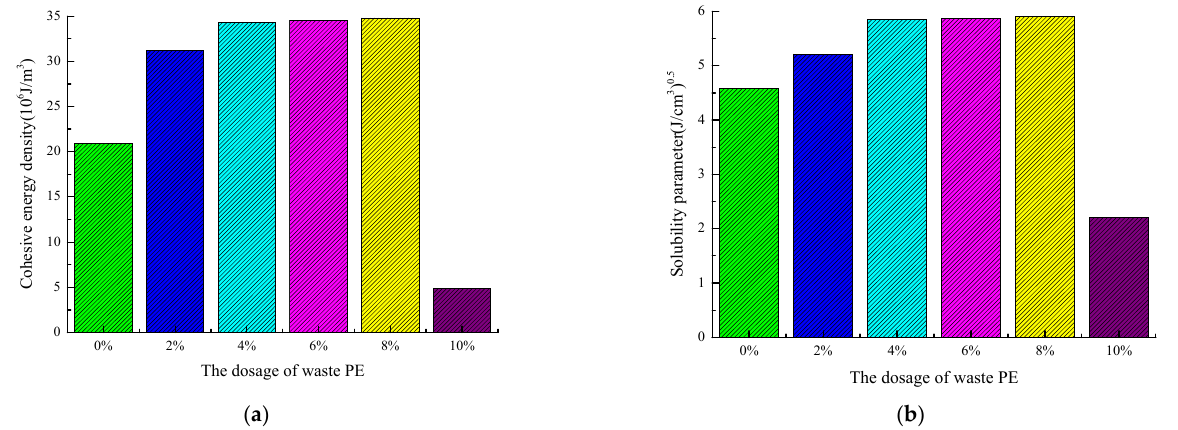
Figure 6. Free volume of waste plastic/rubber-modified asphalt with different percentages of waste polyethylene: ( a ) 0% waste PE; ( b ) 2% waste PE; ( c ) 4% waste PE; ( d ) 6% waste PE; ( e ) 8% waste PE; ( f ) 10% waste PE.